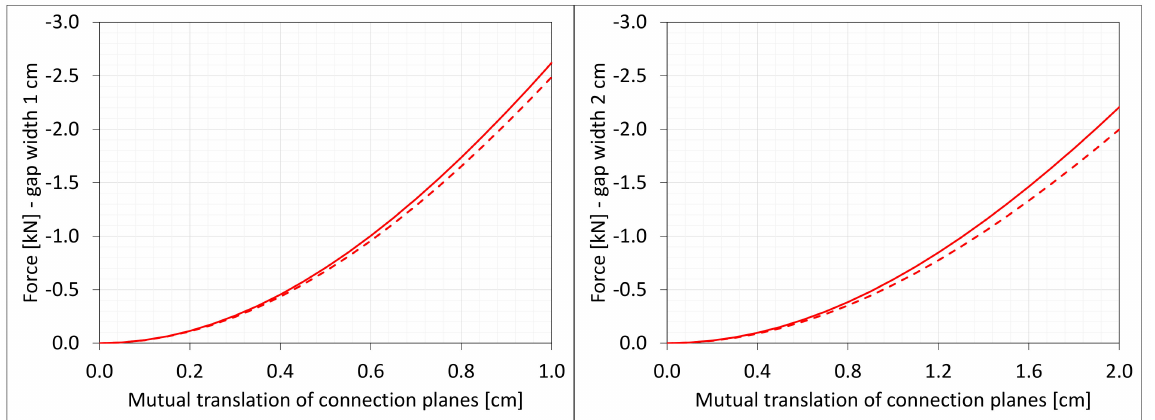
Figure 30. Equilibrium paths for axial force N z . The width of the gap is equal to 1.0 cm, left graphic, and 2.0 cm, right graphic. Plane strain models, solid lines; and 3D models, dashed lines (curves from Figure